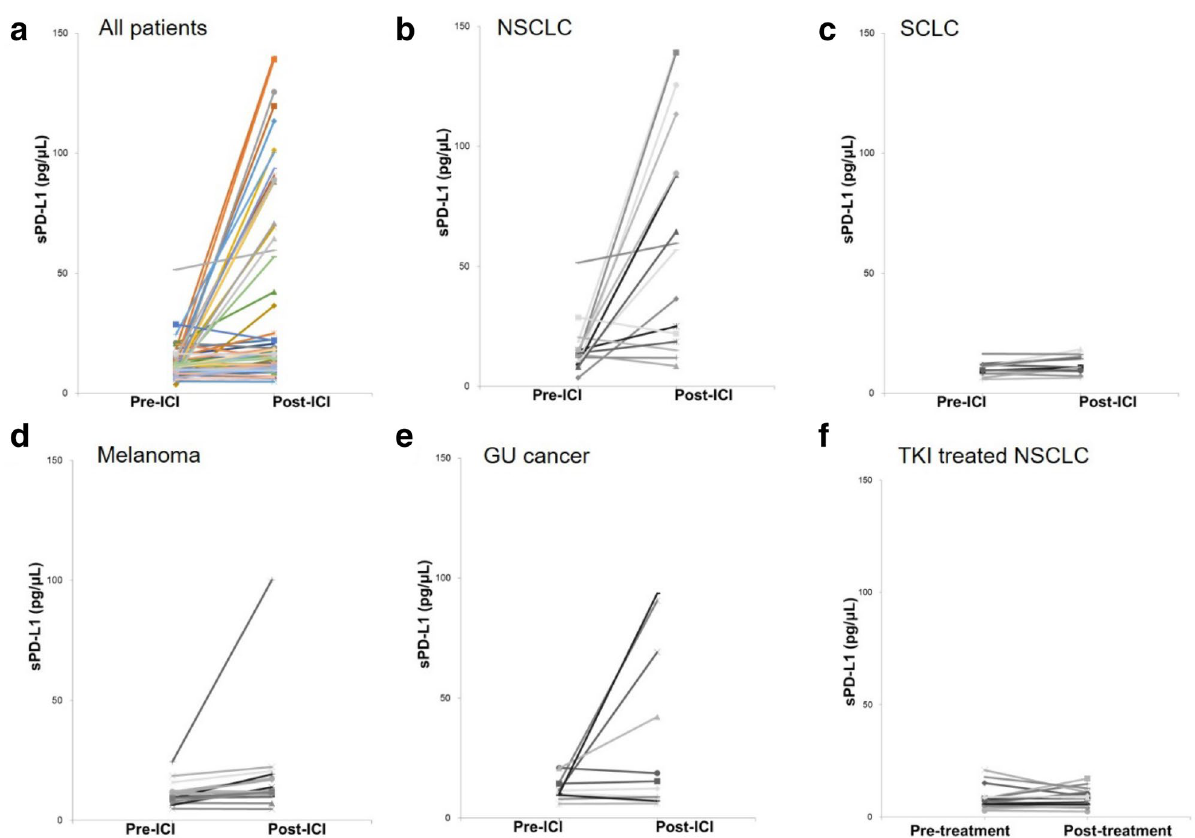
Figure 2. Changes in sPD-L1 levels before and after treatment, according to cancer type and treatment type in all patients ( a ), NSCLC patients ( b ), SCLC patients ( c ), melanoma patients ( d ), GU cancer patients ( e ),